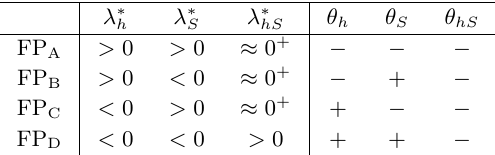
Table 4 . The sign of real fixed points of the system ( λ h , λ S , λ hS ) (left-hand side box) and the signs of the corresponding critical exponents (right-hand side box) for f